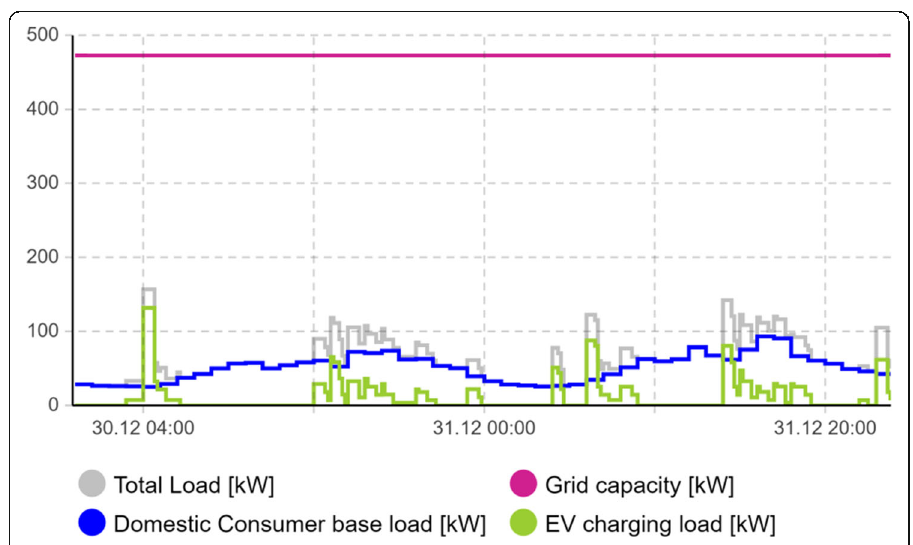
Fig. 14 Simulation model output – loads on the DistributionGrid